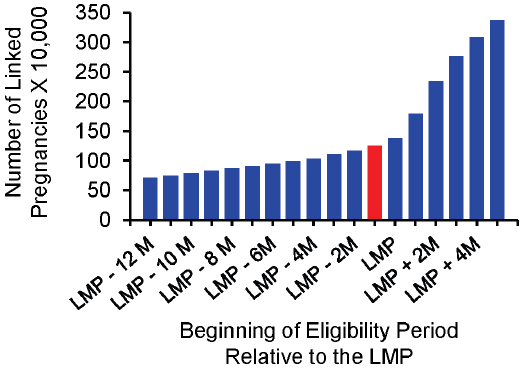
Figure 4. Cohort size by eligibility period; Medicaid Analytic eXtract, 2000–2007. The number of pregnancies in the base cohort